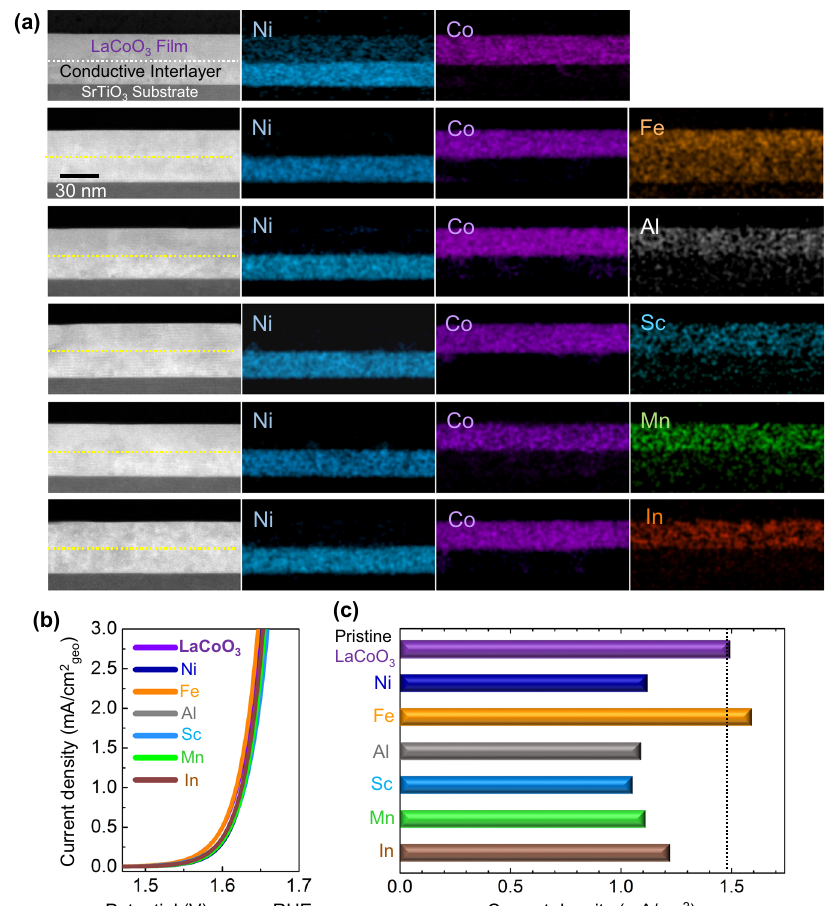
Fig. 6 Fabrication of LaCoO 3 heteroepitaxial (001) cubic thin fi lms with dopants. a A LaNiO 3 metallic interlayer was utilized in all the thin fi lms, as shown in the Ni map. This whole series of EDS maps also veri fi es the homogeneous distribution of the dopants in the fi lms. The doping level was adjusted to be 10%. b This plot shows the variation of the OER current density of the fi lms with 5% doping as a function of applied potential vs. RHE. No substantial enhancement of the OER current by doing is identi fi ed. c The bar graph indicates the OER current densities of the doped (001) surfaces measured at 1.63 V vs.